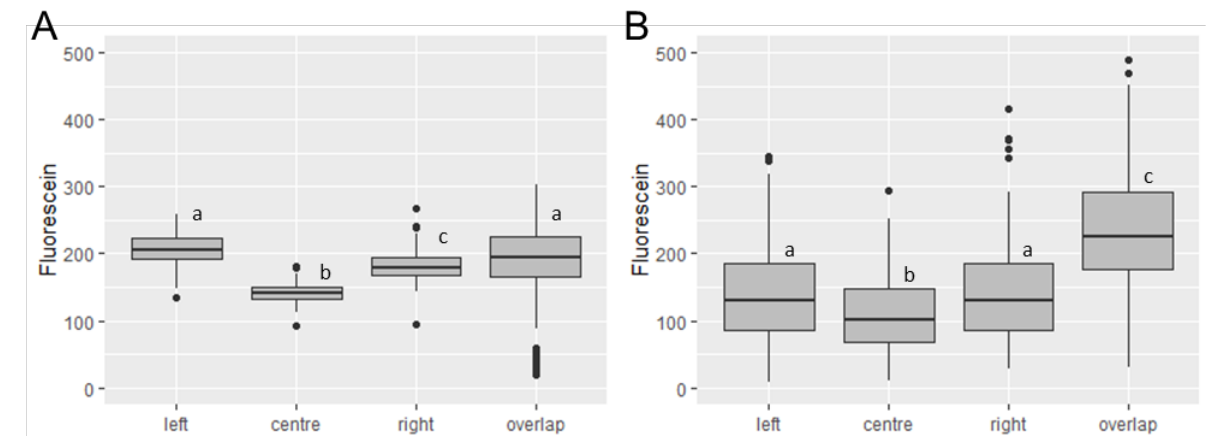
Figure 4. Box and whisker plots of horizontally stratified fluorescence. Track ( A ) and Manual ( B ) spray data was classified using left, centre, right, and overlap horizontal swath positions. The centre position on the track sprayer showed the most consistent fluorescein deposition. Greater differences were seen between horizontal positions on the track sprayer than the manual spray. Significant differences are indicated by different lowercase letters.